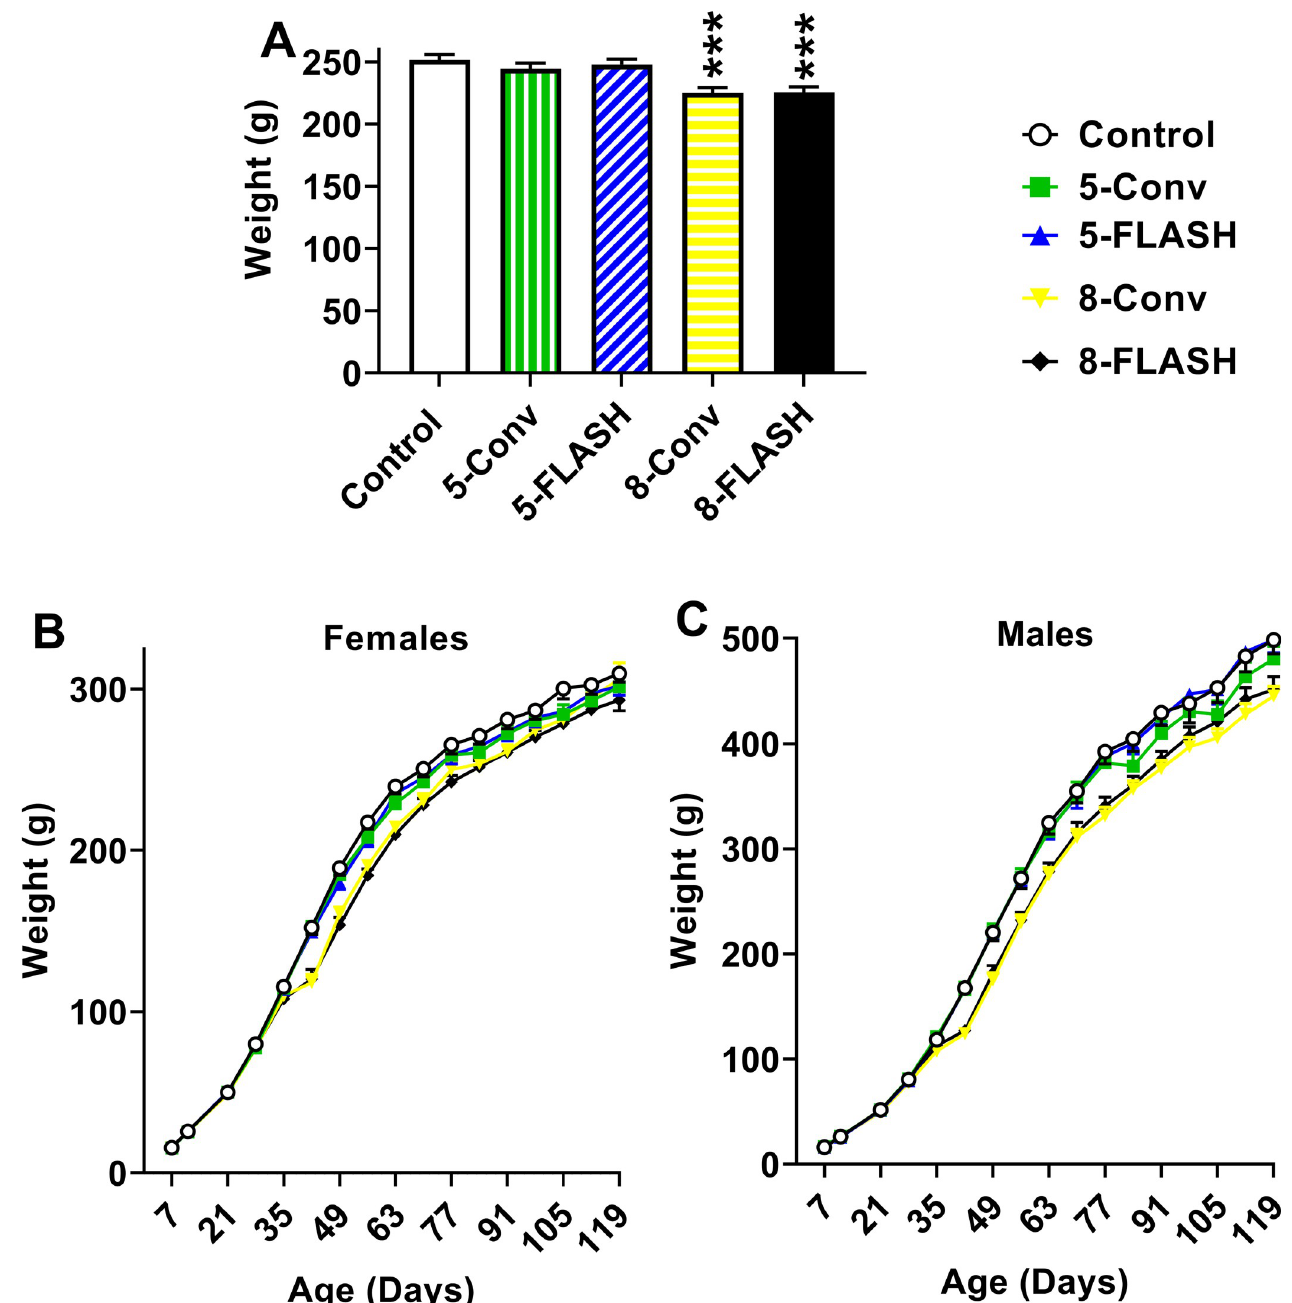
Fig 2. Body weights [g (mean ± SEM)] of proton irradiated and control rats. A . The overall effect on body weights by exposure group, averaged across sex and week. B . Body weights of females by weeks. C . Body weights of males by weeks. While there was an exposure × sex interaction, both females and males dosed with 8 Gy were lighter than controls. See text for a summary of the exposure × age interaction. ��� p < 0.001 compared with controls. N = 14-19/sex/ exposure at each week. Due to scheduling errors some of the body weights were missed on some